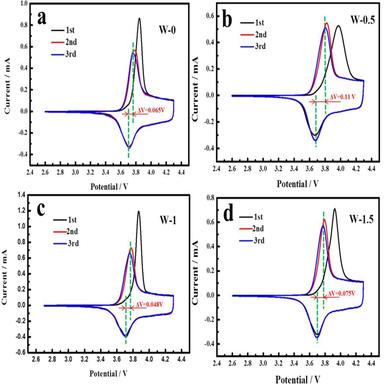
CV curves of bare W-0 (a), W-0.5(b),W-1 (c) and W-1.5(d) between 2.6 and 4.3 V at a scan rate of 0.1 mV s−1 .